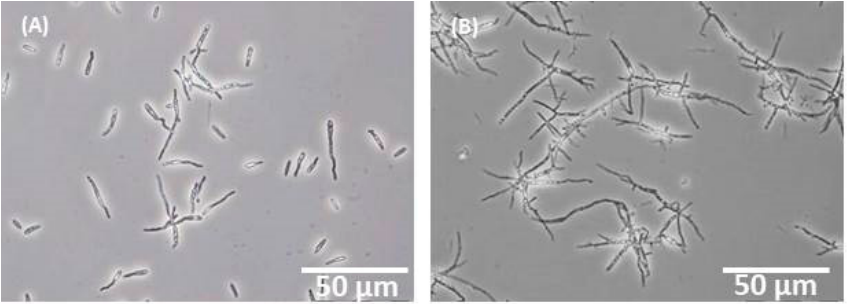
Figure A2. Corresponding morphology of U. rabenhorstiana in a fed-batch cultivation in 1 L-bioreactor (Section 3.7.) after 1.1 days ( A ) and 6.6 days ( B ). Table A1. Analysis of fatty acids in intracellular lipid droplets in U. rabenhorstiana of a fed-batch cultivation in 1 L-bioreactor (Section 3.7.).